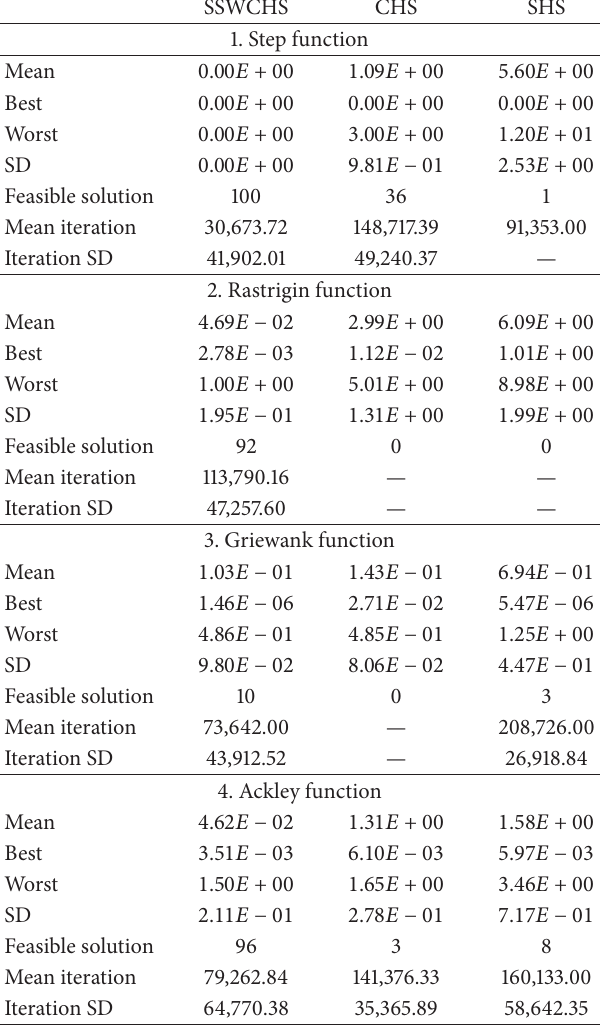
Table 5: Results of 30ND